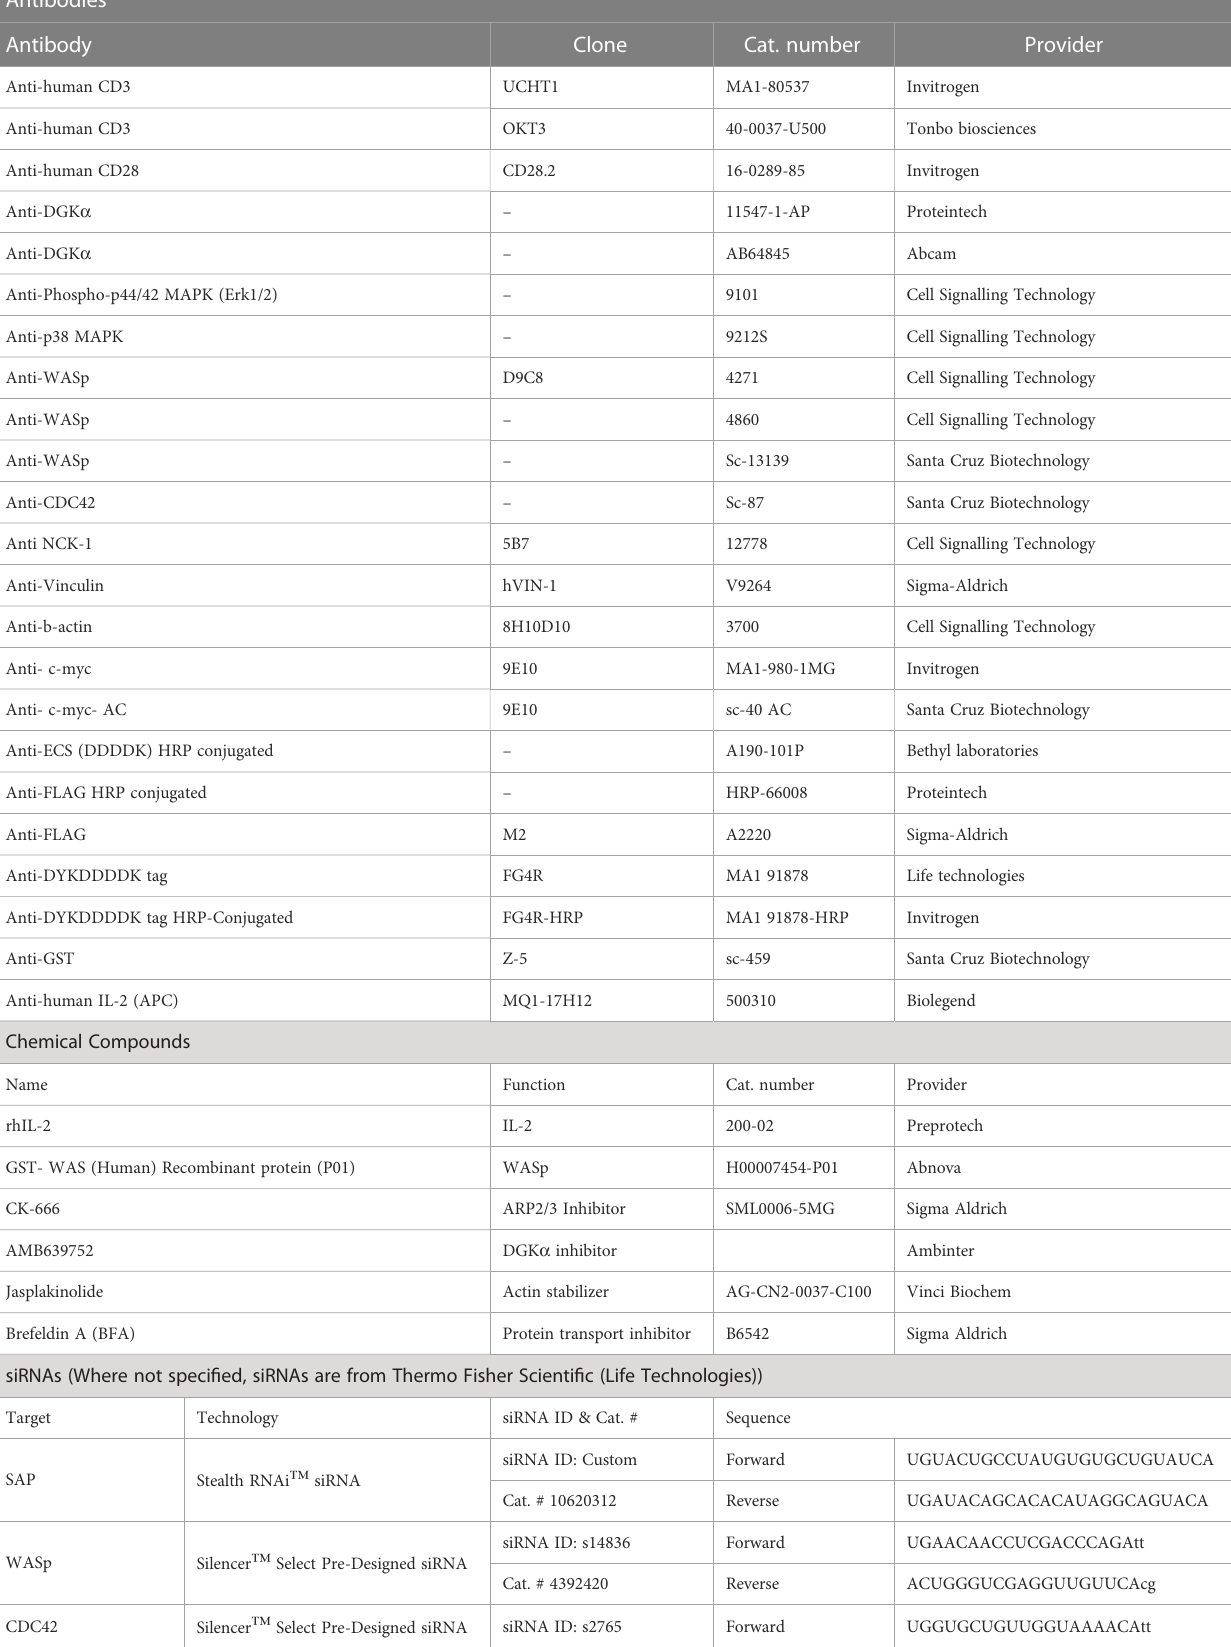
TABLE 1 Detailed list of lab reagents used in the present